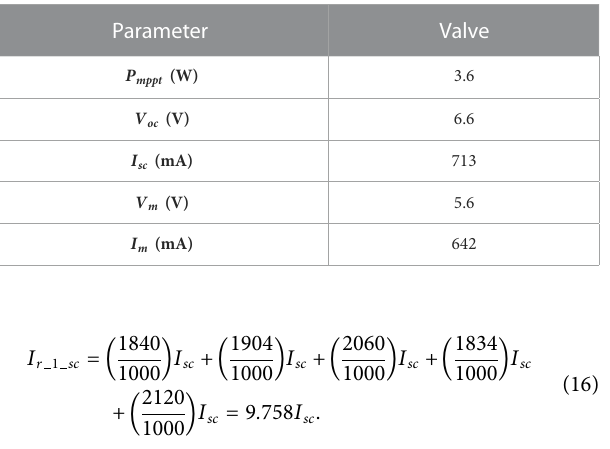
TABLE 6 Parameters of the PV module for this experiment (STC).